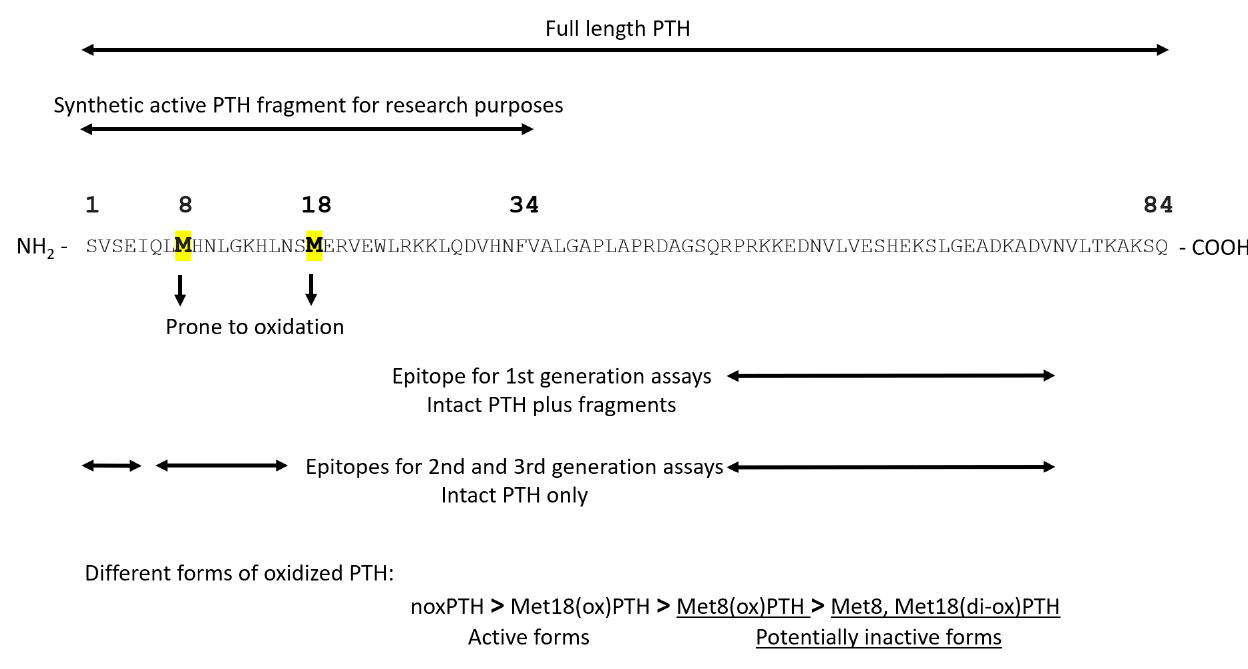
Figure 3. Structure of PTH and its available assays. The letters represent the IUPAC codes for amino acids; PTH = parathyroid hormone; noxPTH = non-oxidized PTH; Met = methionine; ox = oxidized; and di-ox = di-oxidized.